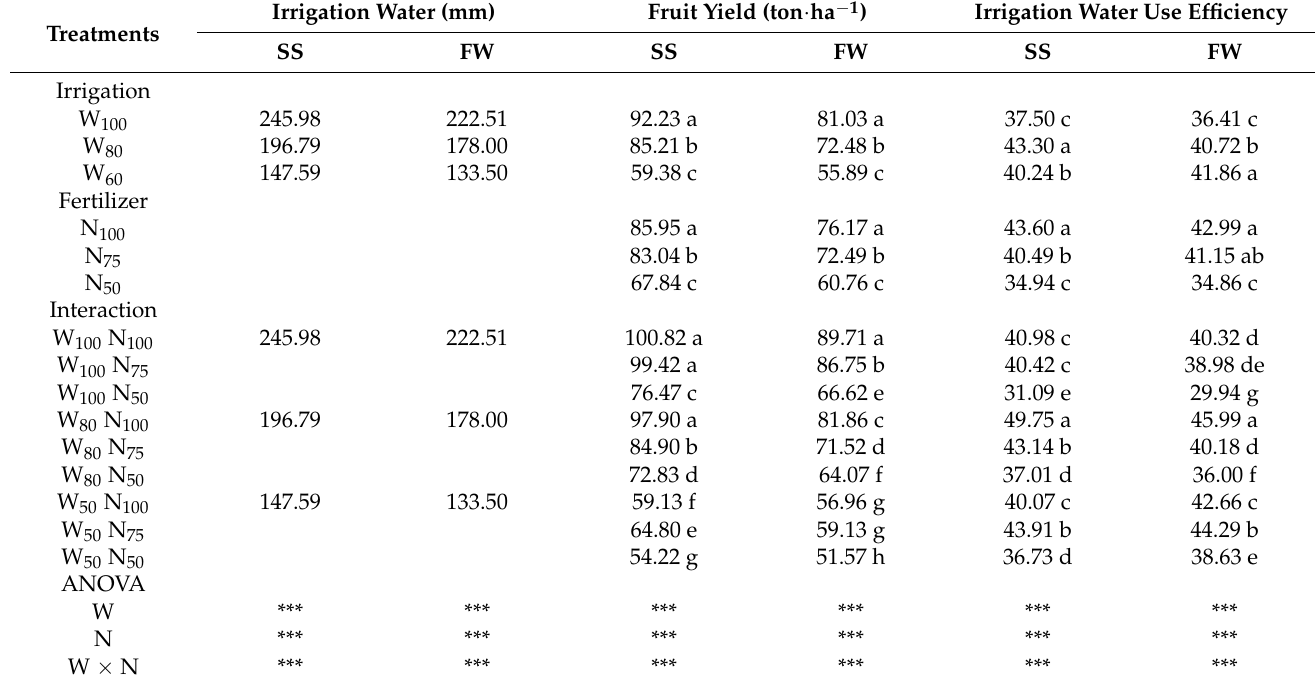
Table 5. Effect of W and N on water used, fruit yield, and irrigation water use efficiency.